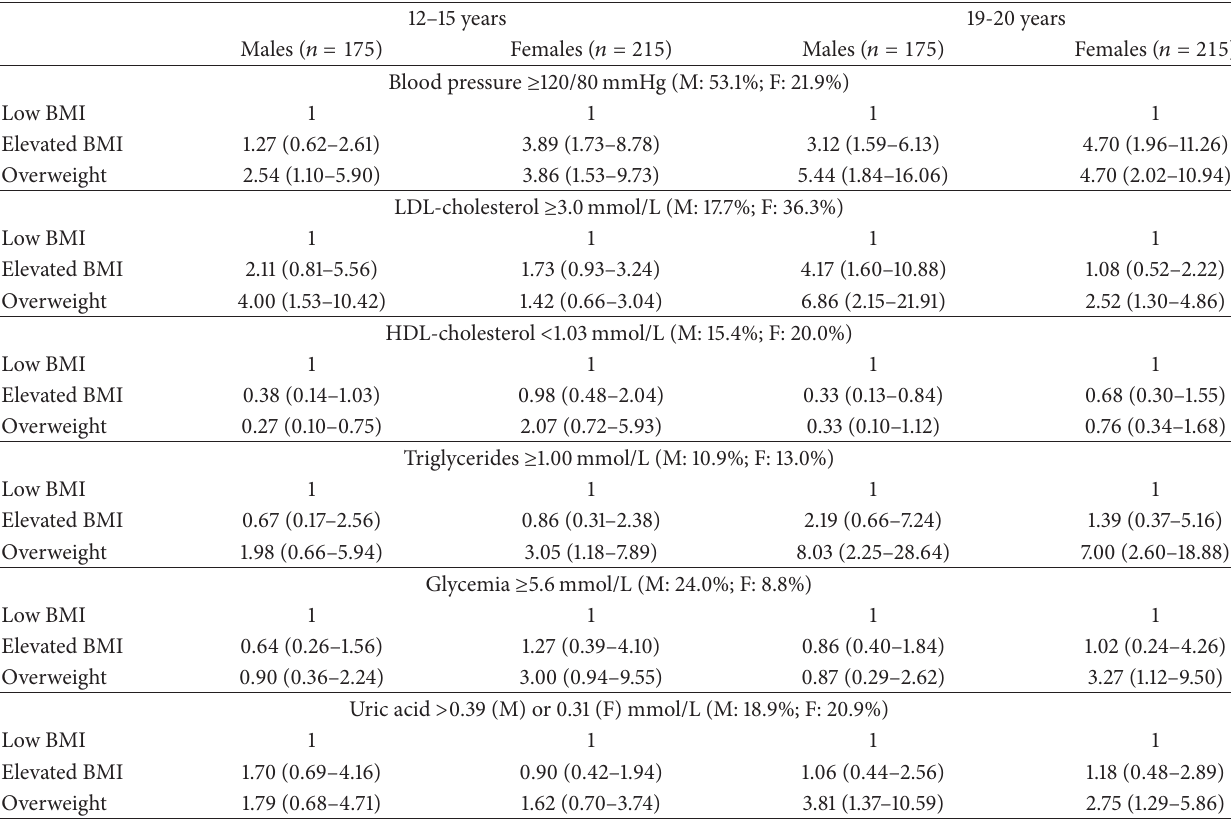
Table 3: Odds ratios for the association between cardiometabolic risk factors at the age of 19-20 years and body mass index categories measured at the age of 12–15 years or at the age of 19 years.